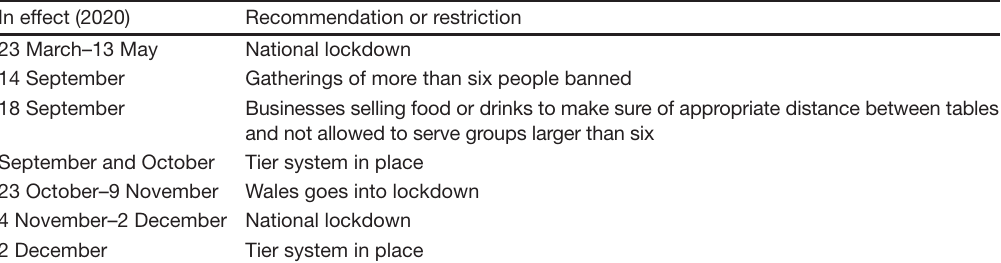
Table A6. List of recommendations and restrictions in the UK during